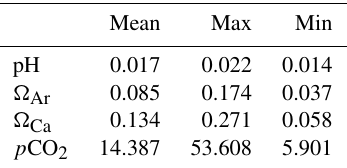
Table 2. Uncertainties ( σ point , mean, max, and min) in pH, (cid:127) Ar , (cid:127) Ca , and p CO 2 (µatm), as calculated from the individual observa- tions described in Sect.